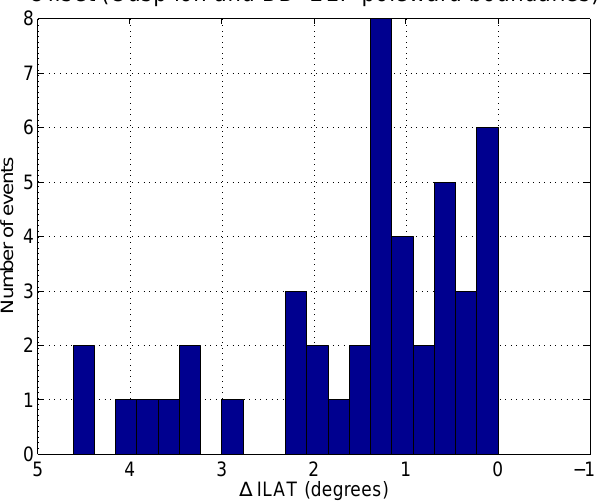
Fig. 7. Histogram of the latitudinal distance between the poleward end of the cusp ion dispersion and the poleward end of the BB-ELF region. A positive value means the ion dispersion extends poleward of the BB-ELF